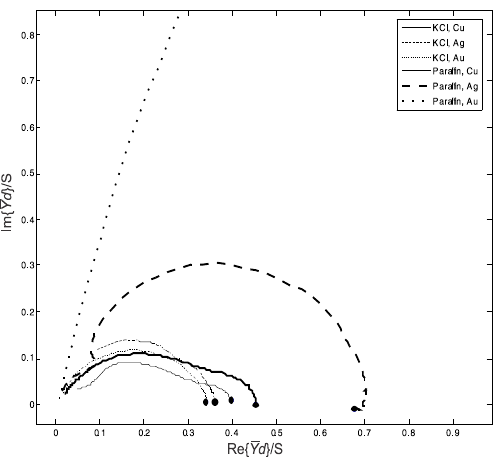
Fig. 10: Double layer impedance extracted from the measured total impedance for different electrodes and media with a suspension of microcapsules or only KCl solution.